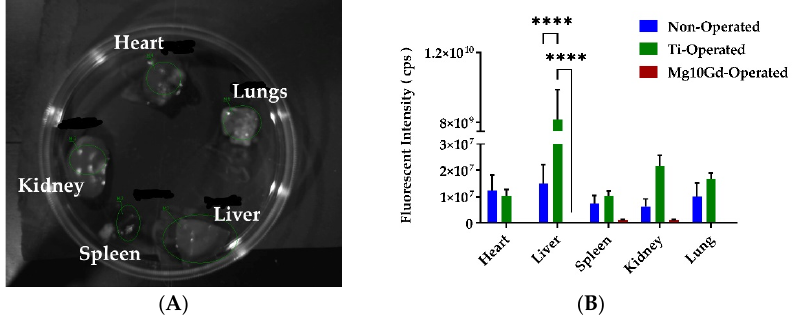
Figure 8. The analysis of ICG fluorescence from ex vivo collected organs to evaluate the biodistribution of α -MSH-SM-liposomes among the three groups. ( A ) Representative image depicting the setup of organs for accumulation or retention analysis of ICG fluorescence. ( B ) Signal retention or accumulation of α -MSH-SM-liposomes in all three treatment groups (non-operated, Mg, and Mg-10Gd) 72 h after liposome injection. ICG fluorescence was measured from heart, liver, spleen, kidney, and lung using NightOwl. Data are expressed as the mean ± standard error of the three animals per group; **** p < 0.0001.